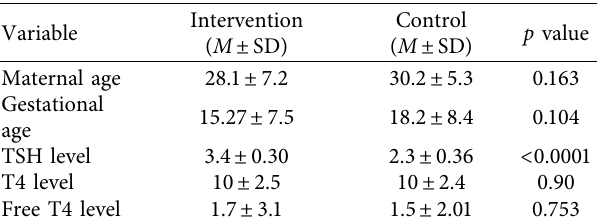
Table 2: Comparison of the baseline quantitative and clinical variables between the intervention and control groups (mean ± SD).